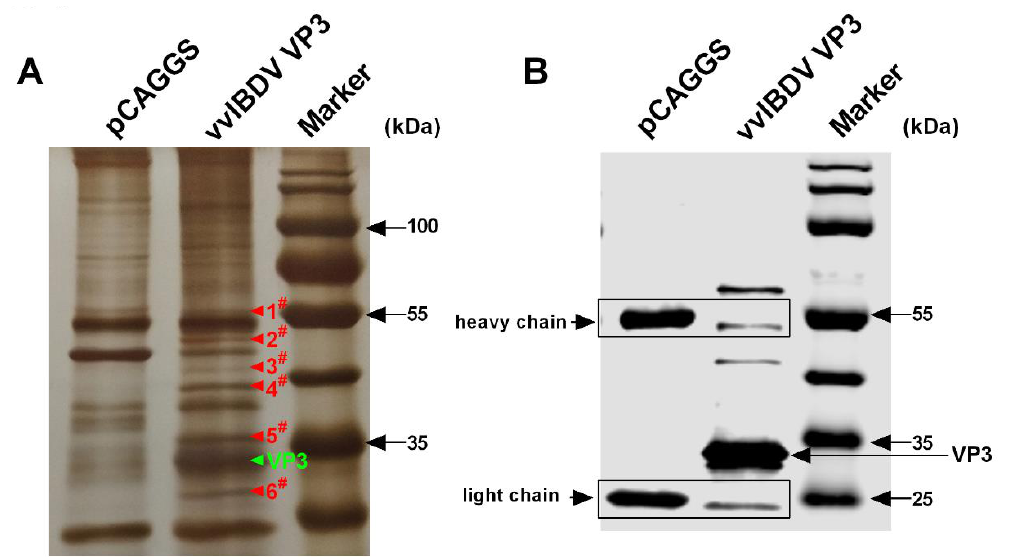
Figure 1. Very virulent infectious bursal disease virus (vvIBDV) virus protein 3 (VP3) was used to fish potential associated host factors. ( A ) Six different gel bands were detected in vvIBDV VP3 immunoprecipitated cell lysates compared with pCAGGS vector control sample. DF-1 cells were transfected with eukaryotic expression plasmids harboring the HA-tagged vvIBDV VP3 or